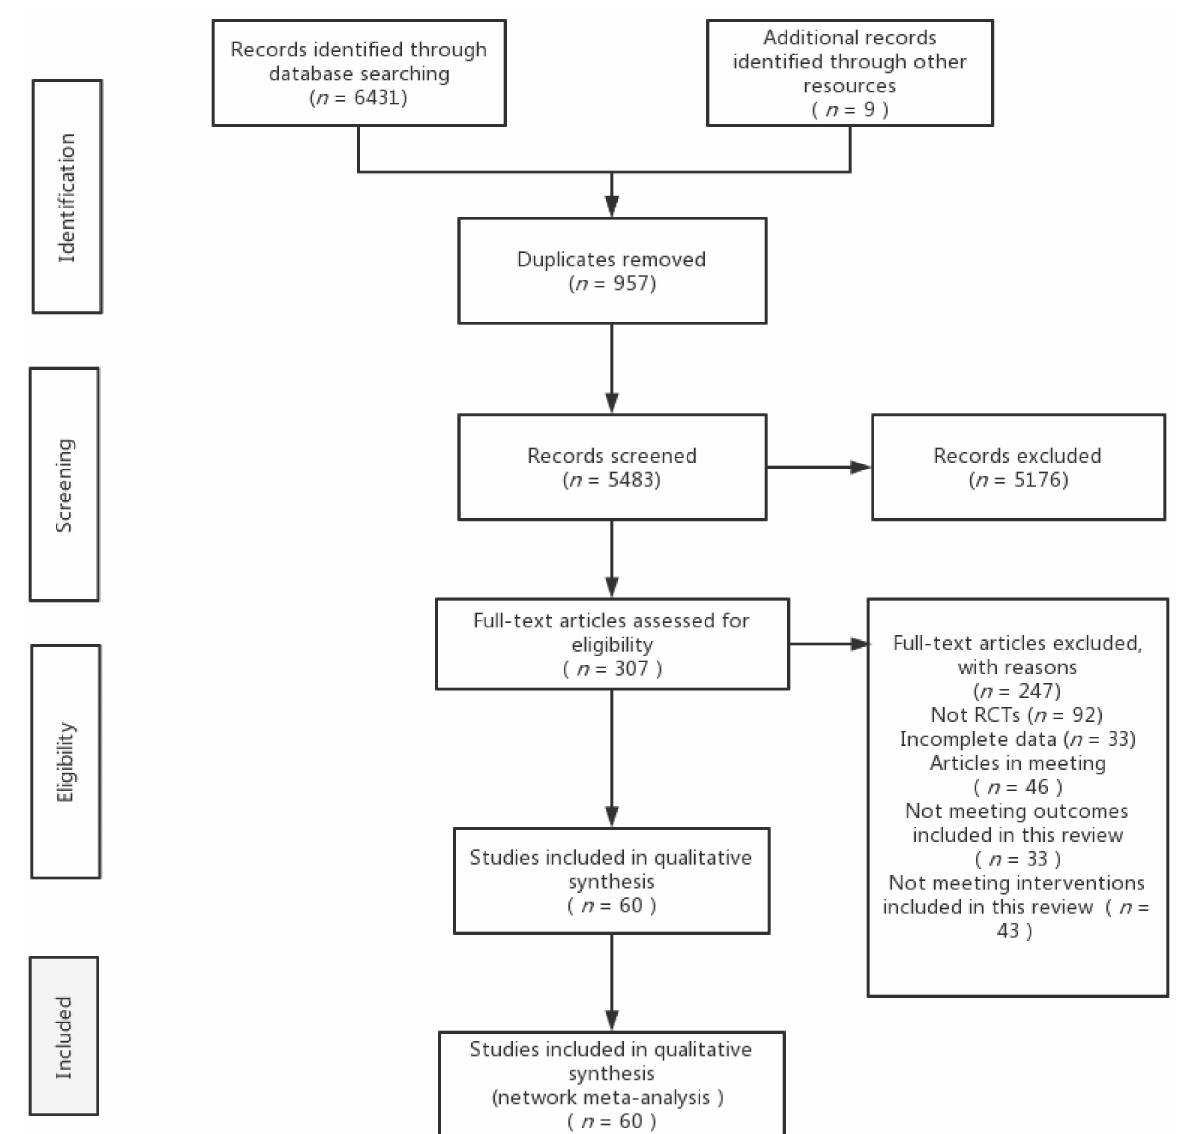
Figure 1. Flow diagram of literature